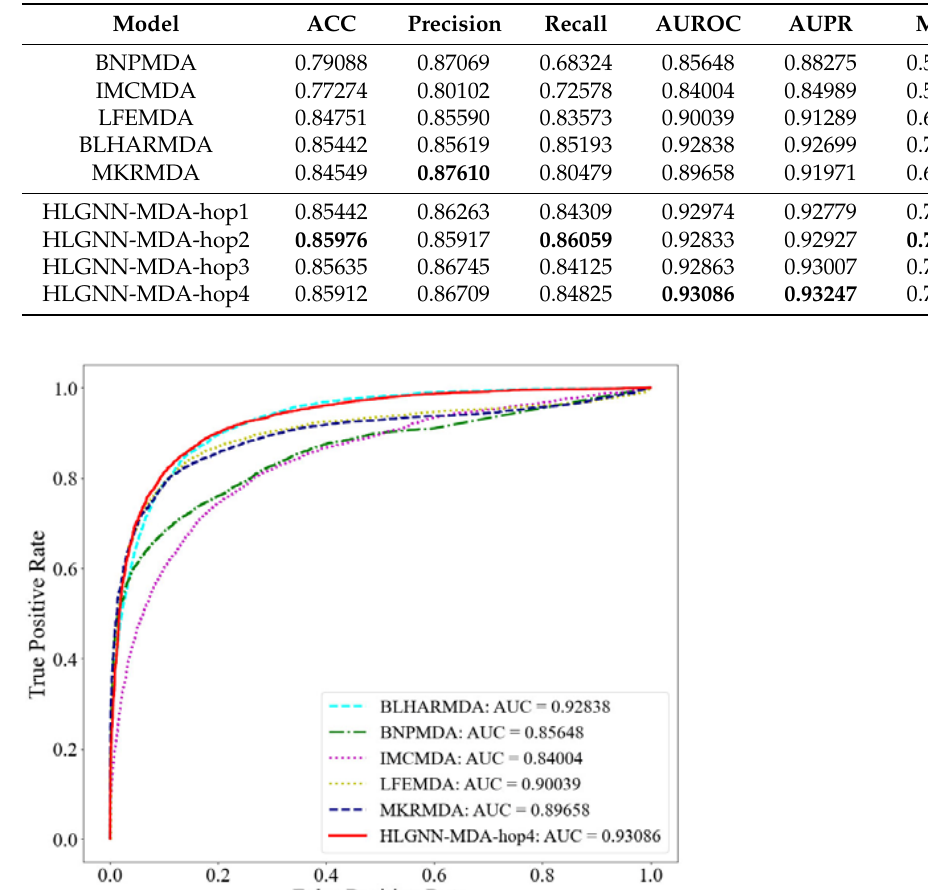
Table 1. Performance analysis of HLGNN-MDA and state-of-the-art miRNA–disease association prediction algorithms. The bold part indicates the maximum value in the corresponding column.